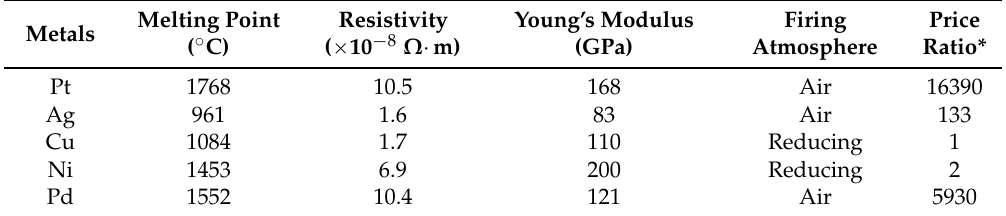
Table 1. Important properties of common metal electrode